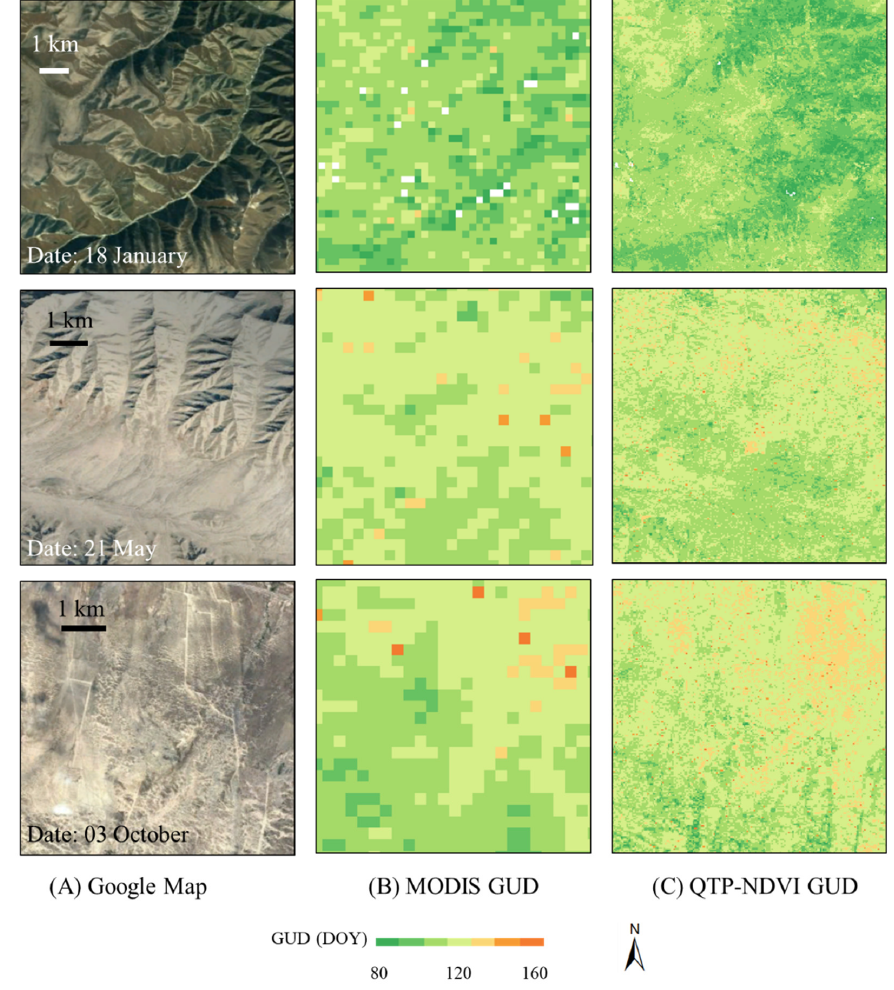
Figure 10. Comparisons between the MODIS-derived 250 m GUD and the QTP-NDVI30-derived GUD in three local areas (points a–c in Figure 9). The high-resolution Google Earth images (left) are included to show landscapes. Google Earth images could not be obtained for the growing season due to availability limitations.